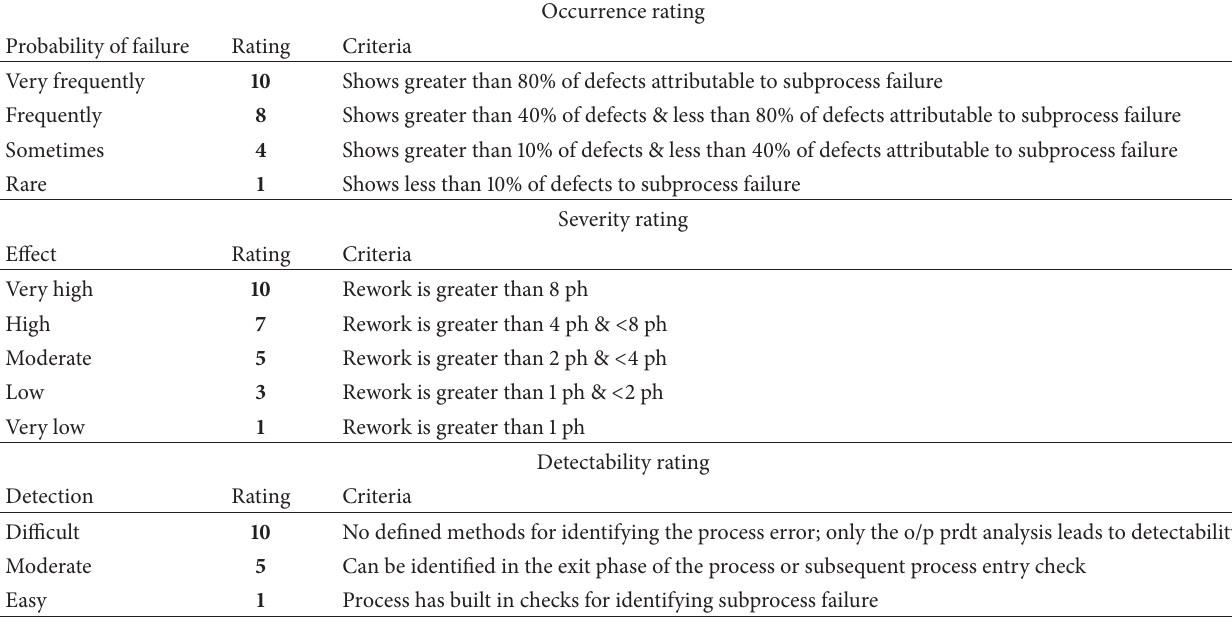
Table 3: Occurrence rating process